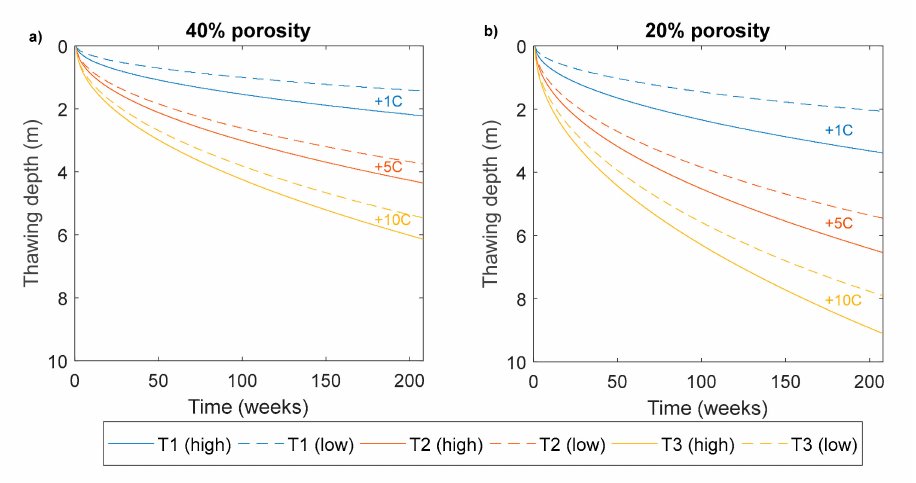
Figure 1. Freezing point isotherm throughout four years for ( a ) high porosity sand, and ( b ) low porosity sand. Both models are displayed for low salinity (dashed lines, freezing point temperature is − 0.17 ◦ C) and high salinity (solid lines, freezing point temperature is − 1.43 ◦ C ) pore water, and for models T1 (top boundary temperature = + 1 ◦ C ), T2 (top boundary temperature = + 5 ◦ C ), and T3 (top boundary temperature = + 10 ◦ C